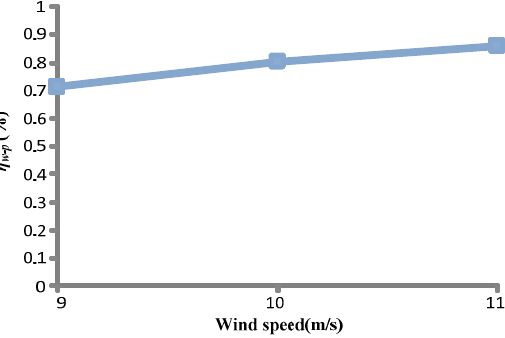
Figure 11. Efficiency of the wind-pump system comparison at different wind speeds.